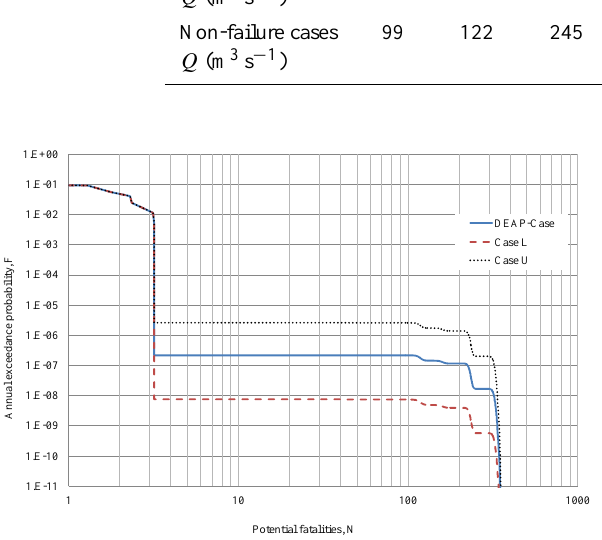
Fig. 14. FD-curves for the DEAP-Case and sensitivity Figure 14. FD-curves for the DEAP-Case and sensitivity analysis. 2